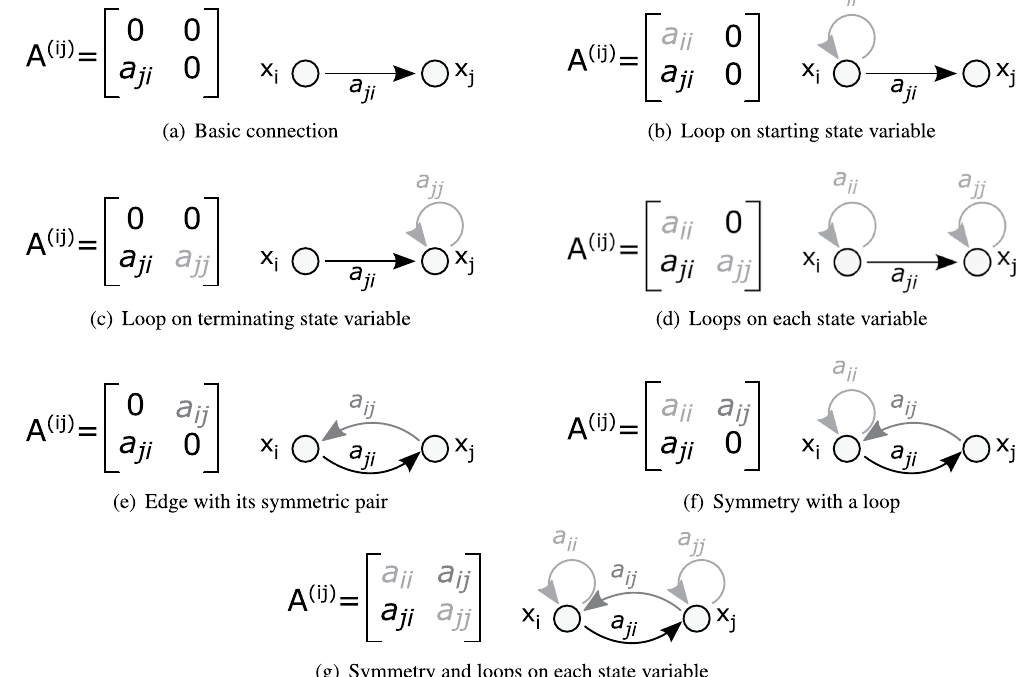
Figure 3. Dynamics of two state variables. ( a ) Basic connection without additional edges represents the ‘logical’ or ‘structural’ relationship between the elements. ( b ) Source state variable influences itself as well, for example, it represents a variable that has a capacity which changes due to the connection. ( c ) The change of the terminating state variable also depend on its value, e.g. accumulation. ( d ) Combined dynamics of types ( b , c ). ( e ) The symmetric edge-pair shows that the influence is undirected, or the strength of the influence depends on the other state variable, as the signal flows in causal bond graphs 16 . ( f ) Combined dynamics of types ( b , e ). ( g ) Combined dynamics of types ( d , e ).